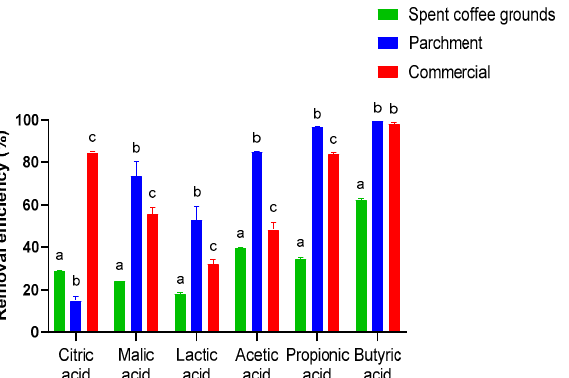
Figure 6. Effect of citric, malic, lactic, acetic, propionic, and butyric acid adsorption on spent coffee grounds, parchment, and commercial activated carbons. An amount of 200 g/L in the bulk solution was used, with an adsorbent dose of 10% ( w / v ) and 4 h contact time at room temperature. Data are expressed as means ± standard deviation ( n = 3). Different letters indicate significantly different values for each group (different superscript letters indicate a significant difference, p < 0.05, two-way ANOVA, Tukey’s test).